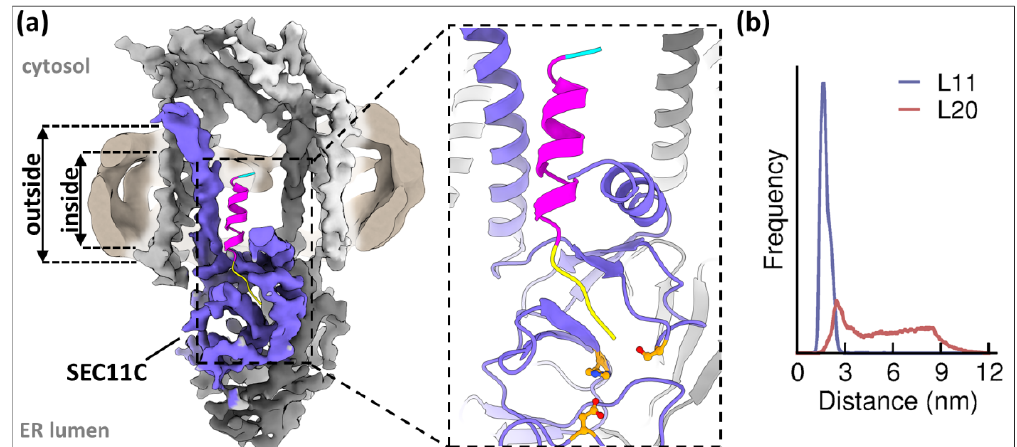
Figure 6. SP removal by the signal peptidase complex. ( a ) Atomic model of an SP fitted into the binding pocket of SPC-C (shown as EM map, catalytic subunit SEC11C purple, SEC22/23 dark gray, SPC25 gray, SPC12 light gray; EMDB-13172). The micelle (show in the background in pale yellow) is thinned inside the TM window and measures the length of the h-region. The blowup shows the binding groove for with the SP c-region and the catalytic residues of SEC11C (orange). Residues − 1 and − 3 point towards the bottom of the pocket and therefore need to be short and hydrophobic. ( b ) Coarse-grained molecular dynamics simulations show the mean distance of an SP with 11 residues (L11) and 20 residues (L20) from the binding pocket. Long h-regions are excluded by the thinned membrane in the TM window. Figure based on [5].